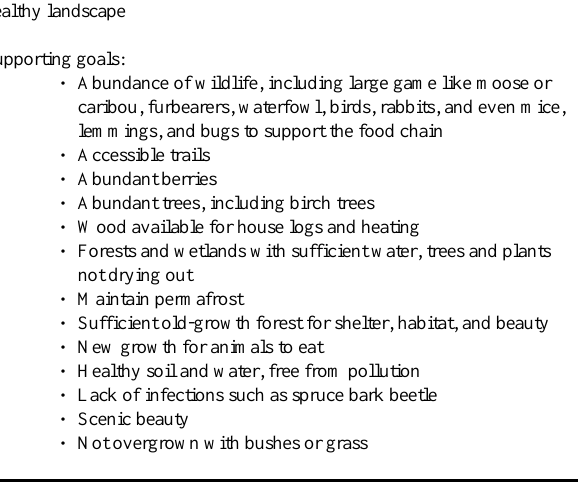
Table 1 . Koyukon respondent forest goals.